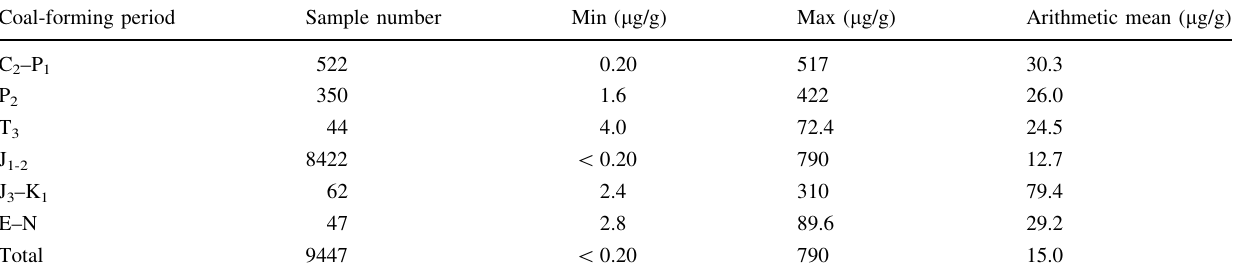
Table 1 Lead concentrations in Chinese coals from the main coal-forming periods Coal-forming period Sample number Min ( l